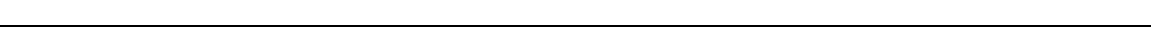
Fig. 3 The intracellular domain of FAT1 interacts with and activates the Hippo kinase signalome. a Representative western blots against Hippo pathway components in lysates of exponentially growing HEK293 CD4ext and CD4-FAT1-TM/ICD stable cells. Control, parental HEK293 cell line. b Analysis of YAP1 phosphorylation after transient transfection with CD4 control or CD4-FAT1-TM/ICD chimera in WT or the corresponding CRISPR/Cas9 sgRNA engineered knockout HEK293 cells as indicated. HA-YAP1 immunoprecipitates were analyzed by phos-tag phosphorylation af fi nity shift electrophoresis and YAP1 western blotting. Retarded (phosphorylated) YAP1 is indicated by arrowheads. A representative blot is shown. c Analysis of YAP1 phosphorylation after transient cotransfection with Flag-YAP1 and CD4 control or CD4-FAT1-TM/ICD chimera in HEK293 cells pretreated with control (C) or TAOK1/2/3 siRNA (TAOKs) as indicated. Flag-YAP1 immunoprecipitates were analyzed by phos-tag electrophoresis and YAP1 western blotting. Retarded (phosphorylated) YAP1 is indicated by arrowheads. A representative blot is shown. d On the left, a scheme depicting the GST fusion proteins indicating the approximate location of functional motifs present in FAT1 and LATS1 and the subsequent GST-pulldown assay. On the right, representative western blots of pulldown experiments using GST fusion proteins and HEK293 total cell lysates. e Summary of mutant FAT1 ICD constructs (PPXY and PDZ binding site) and the depicted deletions and their ability to bind MST1 as assessed by pulldown assay. f siRNA-mediated knockdown on HEK293 of the different components of the Hippo signaling pathway and subsequent GST-FAT1-ICD pulldown on whole cells lysates. g Endogenous FAT1 immunoprecipitation by a monoclonal antibody recognizing is extracellular region. Exponentially growing HEK293 were transfected with FAT1 and FAT2 siRNAs for 48 h and then treated for 2 h at 4 °C with DMSO ( − ) or the reversible crosslinker DSP ( + ) prior to cell lysis and immunoprecipitation with anti-FAT1. Representative western blots are